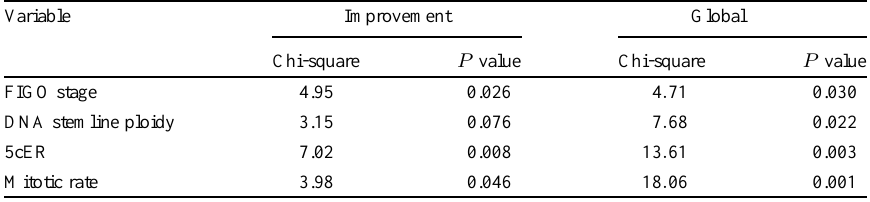
Presurgery available prognostic factors in multivariate analysis (Cox proportional hazards regression model) Variable